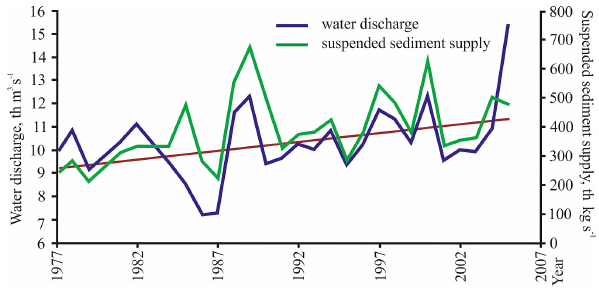
Figure 9. Average annual water discharge (blue line) with trend (red line) and suspended sediment supply (green line) on the Trofi- movskaya branch over the period of instrumental observations ac- cording to data from Roshydromet (Hydrometeoizdat, 2002–2005).